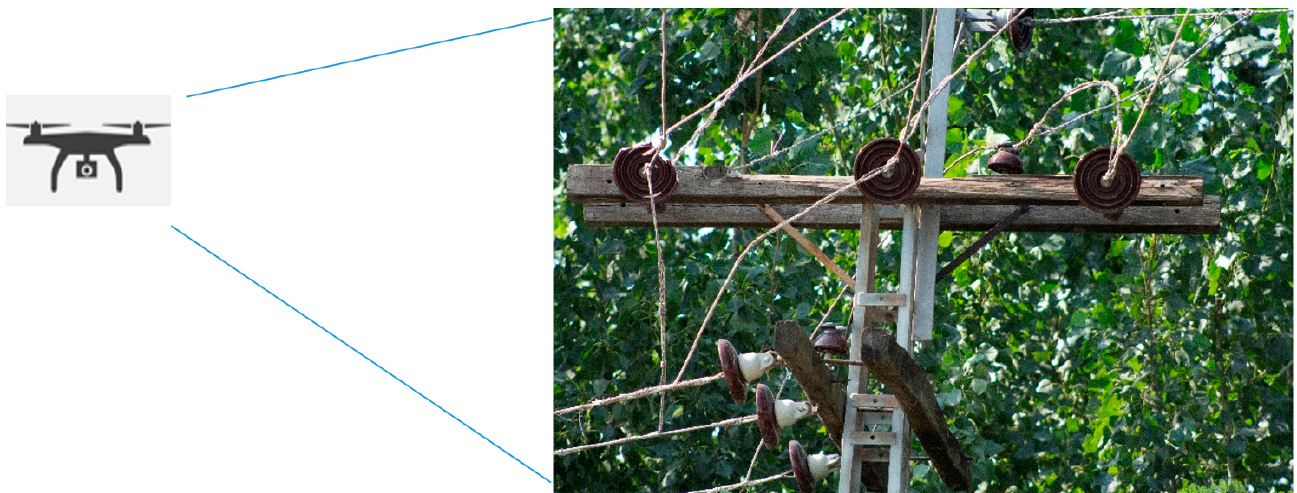
Figure 2. Illustration of overhead power distribution line from drone camera.